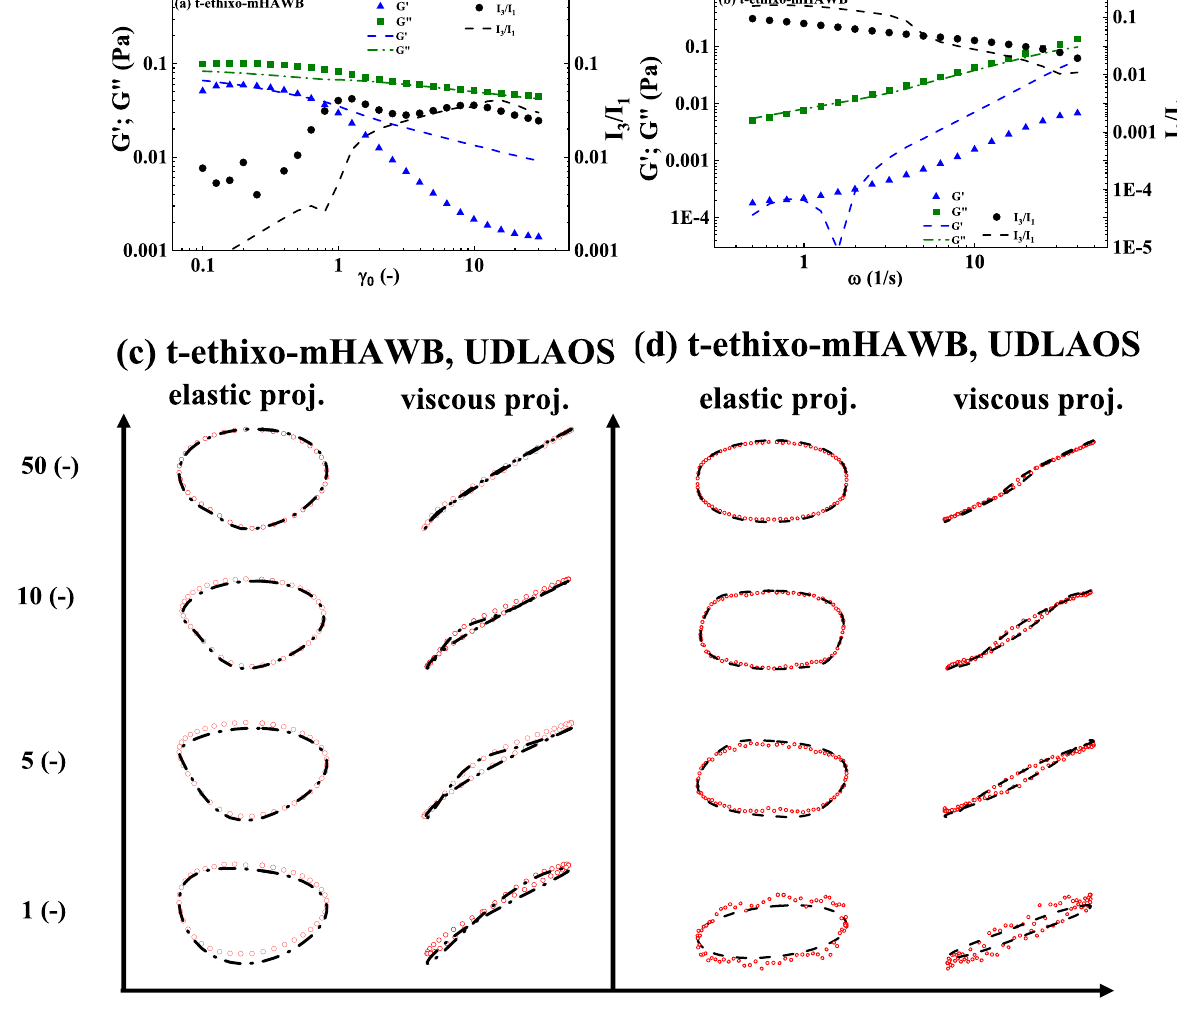
Figure 4. t-ethixo mHAWB prediction of ( a ) Amplitude sweep executed at ω = 12.566 (rad/s); ( b ) frequency sweep executed at γ 0 = 10 ( − ) ; ( c ) elastic and viscous UDLAOS projections (green lines); and ( d ) elastic and viscous LAOS projections (green lines). (All UDLAOS and LAOS were conducted at ω = 1 (rad/s), and corresponding strain amplitude). Red dots indicate data; x-axis units are frequency (rad/s); y-axis units are strain amplitude (−). (Donor 1, Dataset 1) 49 .